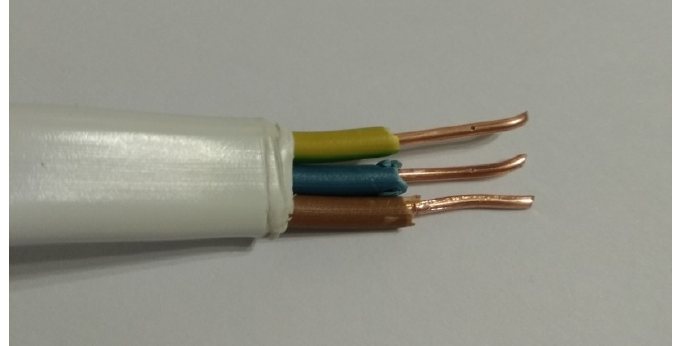
Figure 4. PVC-insulated and sheathed coaxial copper cable (cable specimen No. 4) typically used in electrical installation in buildings. Table 3. Characteristics of cable specimen 4 and test conditions .